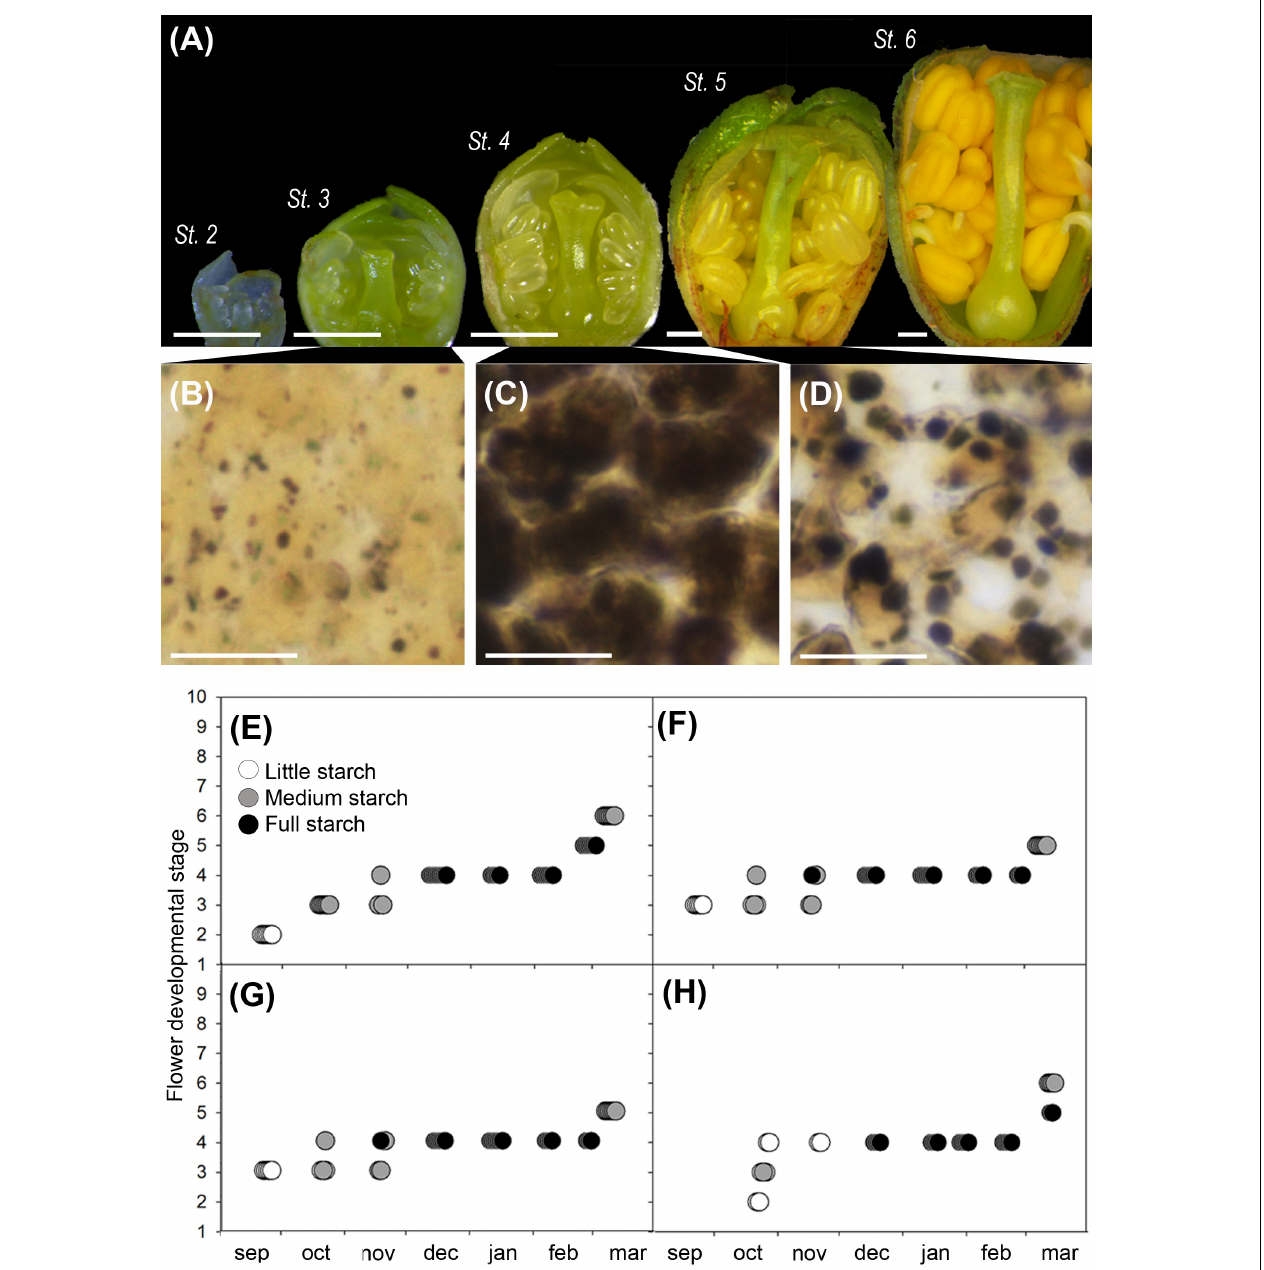
FIGURE 3 | Flower development and qualitative ovary starch evaluation in sweet cherry flower buds. (A) Flower developmental stages (Fadón, 2015): stage 2 (St. 2), early differentiation of the flower whorls; stage 3 (St. 3), the pistil form the suture line; stage 4 (St. 4), incipient ovary, style, and stigma are apparent; stage 5 (St. 5), stigmatic papilla start developing in the spring; stage 6 (St. 6), anthers turn into bright yellow. (B) Histological appearance of ovary cells: with little starch before dormancy (St. 3), (C) full starch content during dormancy (St. 4), and (D) medium starch content after dormancy (St. 5). (E–H) Qualitative ovary starch in relation with flower developmental stage: (E) ‘Bing,’ cold year. (F) ‘Bing,’ mild year. (G) ‘Burlat,’ cold year. (H) ‘Burlat,’ mild year. Bars (A) 500 µ m, (B–D) 20 µ